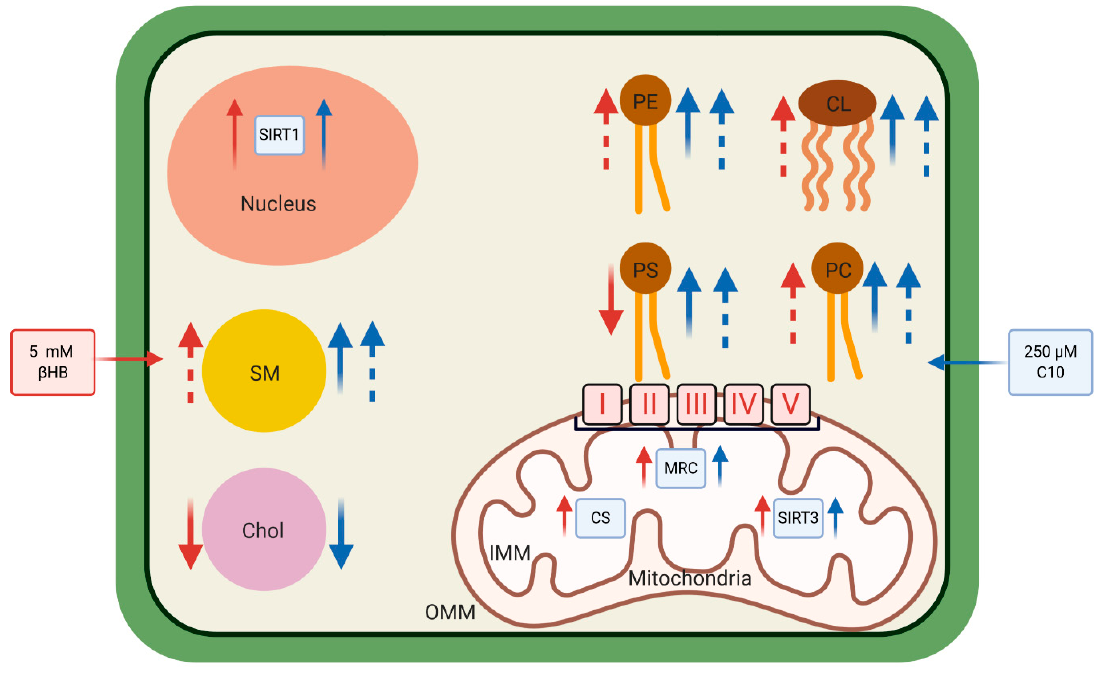
Figure 4. ßHB—Beta-hydroxybutyrate; C10—Decanoic acid; Cho—Cholesterol; CL—Cardiolipin; CS—Citrate Synthase; IMM—Inner mitochondrial membrane; MRC—Mitochondrial Respiratory Chain (I—V are the individual complexes of the MRC); OMM—Outer mitochondrial membrane; PC—Phosphatidylcholine; PE—Phosphatidylethanolamine; PS—Phosphatidylserine; SIRT1—Sirtuin 1; SIRT3—Sirtuin 3; SM—Sphingomyelin. All red arrows depict the effects of ßHB, and all blue arrows depict the effects of C10. Thin arrows show already published data (adapted from [39]). Solid thick arrows show the effects of ßHB and C10 on absolute quantities of the depicted cellular lipids. Dotted thick arrows represent the effects of ßHB and C10 on ratios of the individual phospholipids (and sphingomyelin) to cellular cholesterol. Figure created with BioRender.com.